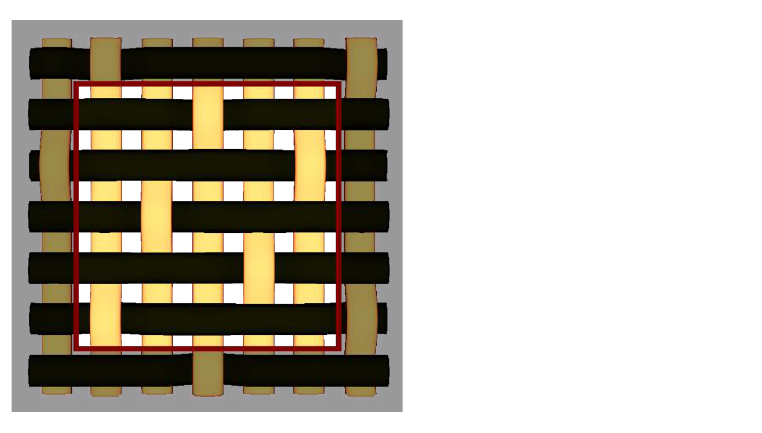
Figure 10. The RUC of satin 5/3/1 relative to a 7 × 7 yarns reference area. The solution found consists of a laminate with 16 layers, having the geometrical parameters for the RUC and LSS given in Table 9. Table 9. The best solution found with satin 5/3/1 fabric as reinforcement. Solution for